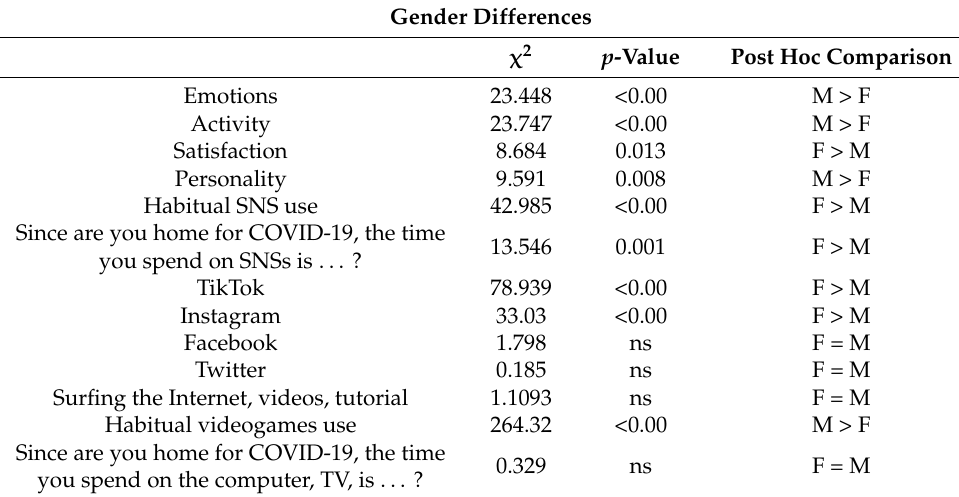
Table 2. Kruskal–Wallis test of gender differences ( N =